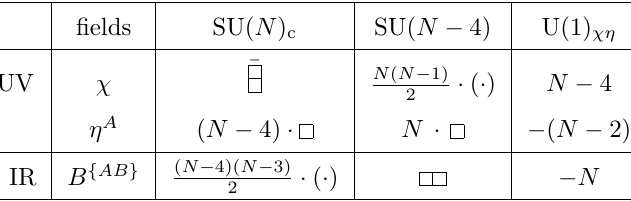
Table 3 . Confinement and unbroken symmetry in the χη